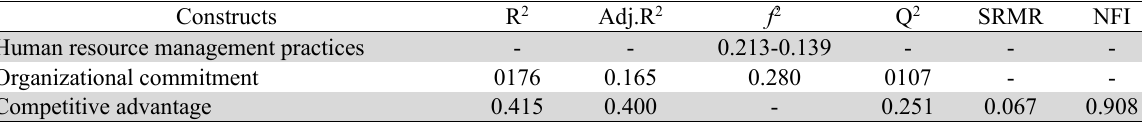
Structural model results